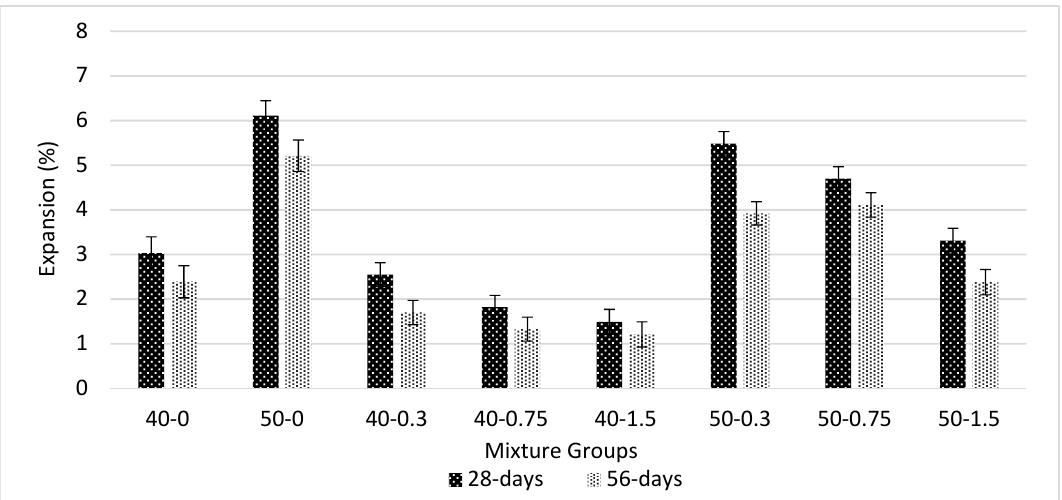
Figure 9. Sulfate resistance test for basalt-reinforced bottom ash cement paste composites at 28 and 56 days of curing.